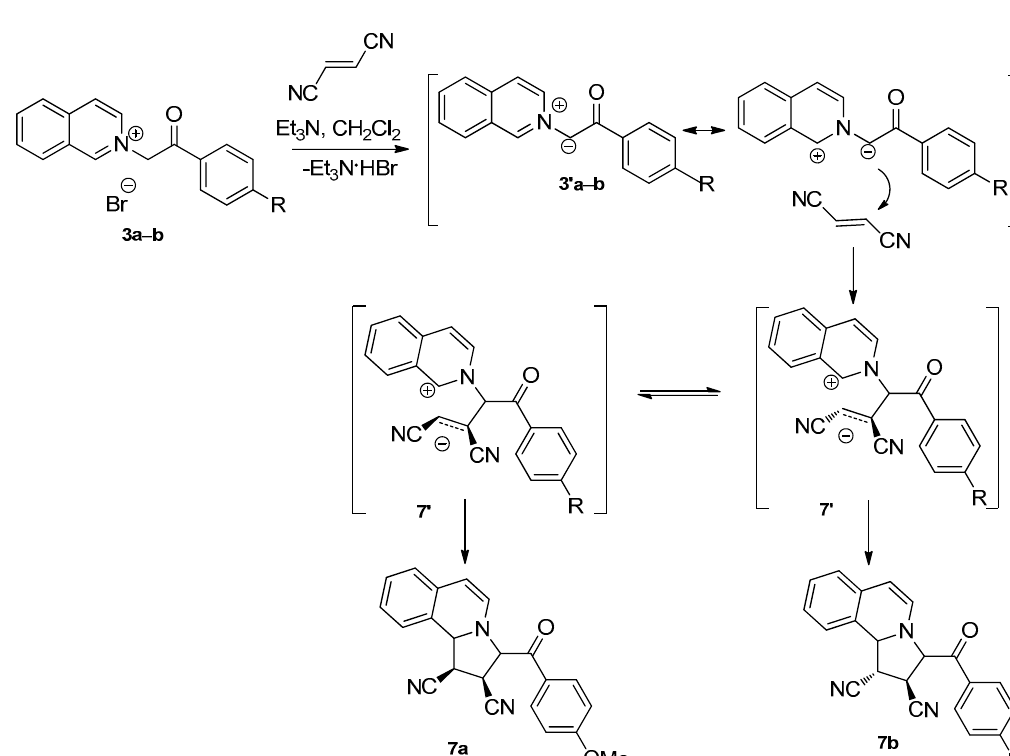
Scheme 4. Synthesis pathway and reaction mechanism for the fused isoquinoline derivatives 7a,b .